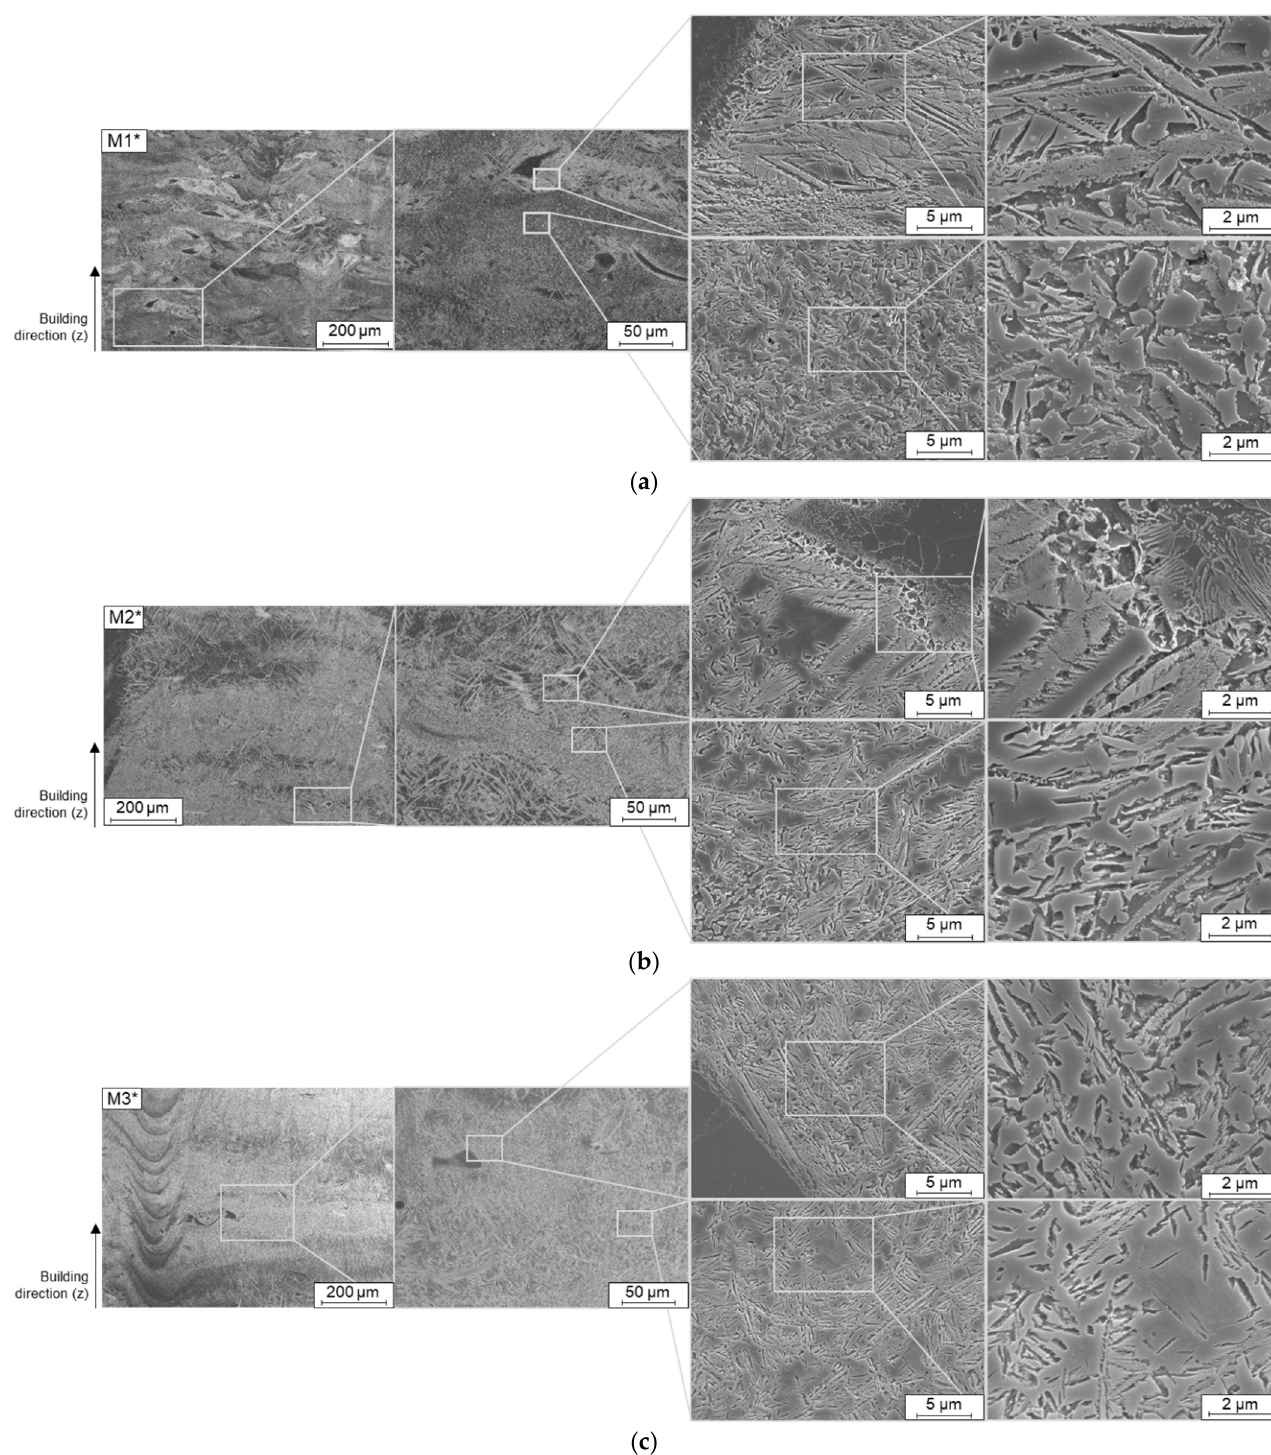
Figure 5. SEM microstructure of ( a ) M1*, ( b ) M2* and ( c ) M3*. M3*, on the other hand, appears finer and more uniform than the other two microstruc- tures, but also shows a few unmolten particles. The detailed images of the microstructures confirm this impression and show a fine needle-like, mostly carbide-free bainitic microstruc- ture with retained austenite